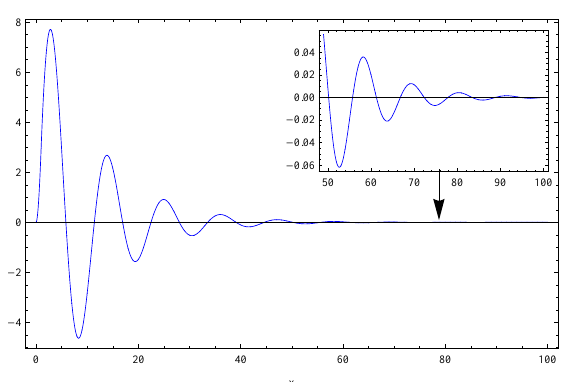
Fig. 6: The Graph of Bagley-Torvik equation using the present method with h = 1 and N = 20 on the interval [0, 100] .